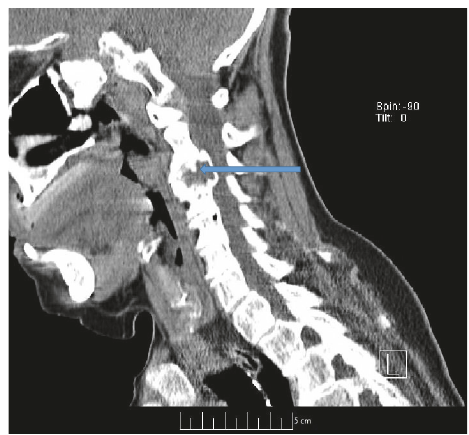
Figure 4: Sagittal CT of cervical spine image showing expansile lesion at C3 with preserved surrounding